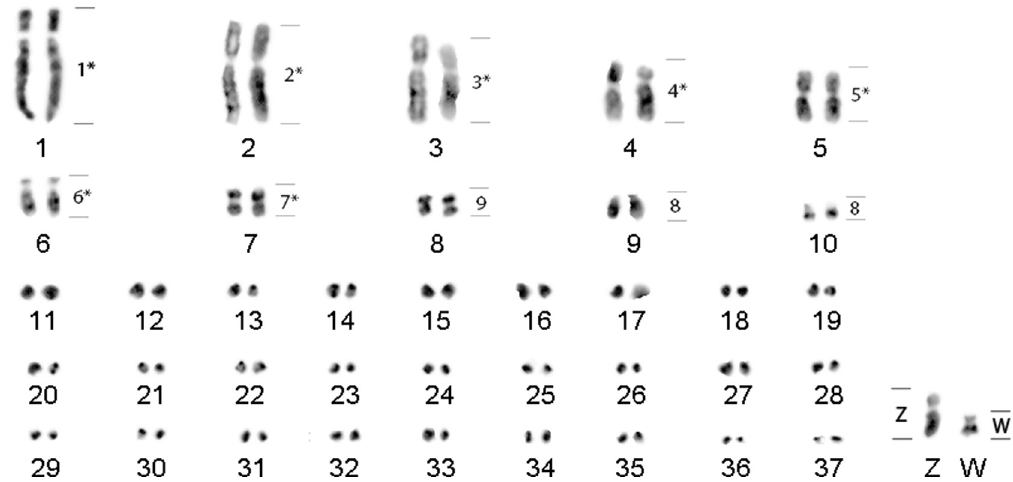
Fig 2. G-banding in Charadrius collaris (2n = 76) showing the homologies of whole chromosome probes of Burhinus oedicnemus (right). ( � ) Macrochromosome probes reveal homeology to the sex chromosome W. The microchromosomes are arranged sequentially, as the correct homeologies cannot be detected due to the lack of reliable